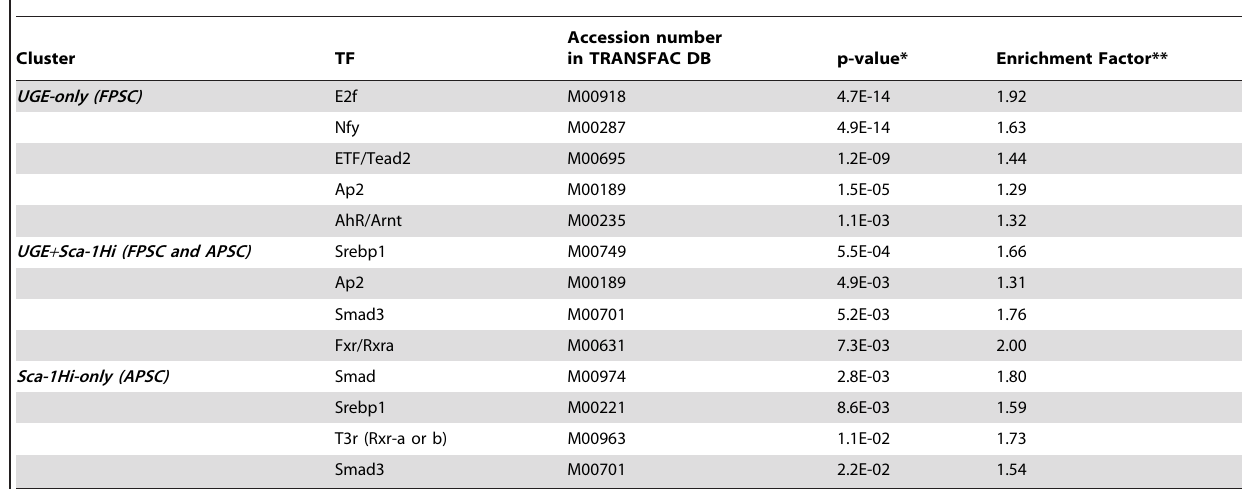
Table 2. Promoter analysis of primitive prostate